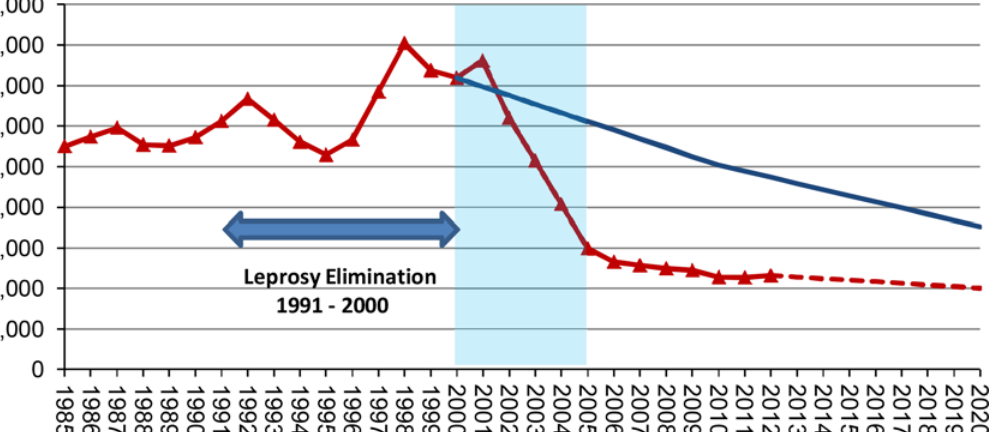
Fig 1. Number of new leprosy cases by year. The red continuous line represents the observed annual new case detection rate between 1985 and 2012, with extrapolation to 2020 based on the trend after 2005 (red dotted line). The blue continuous line is the predicted new case detection rate based on modeling with the SIMLEP model, applying an intermediate scenario in the presence of an infant BCG vaccination programme [7].